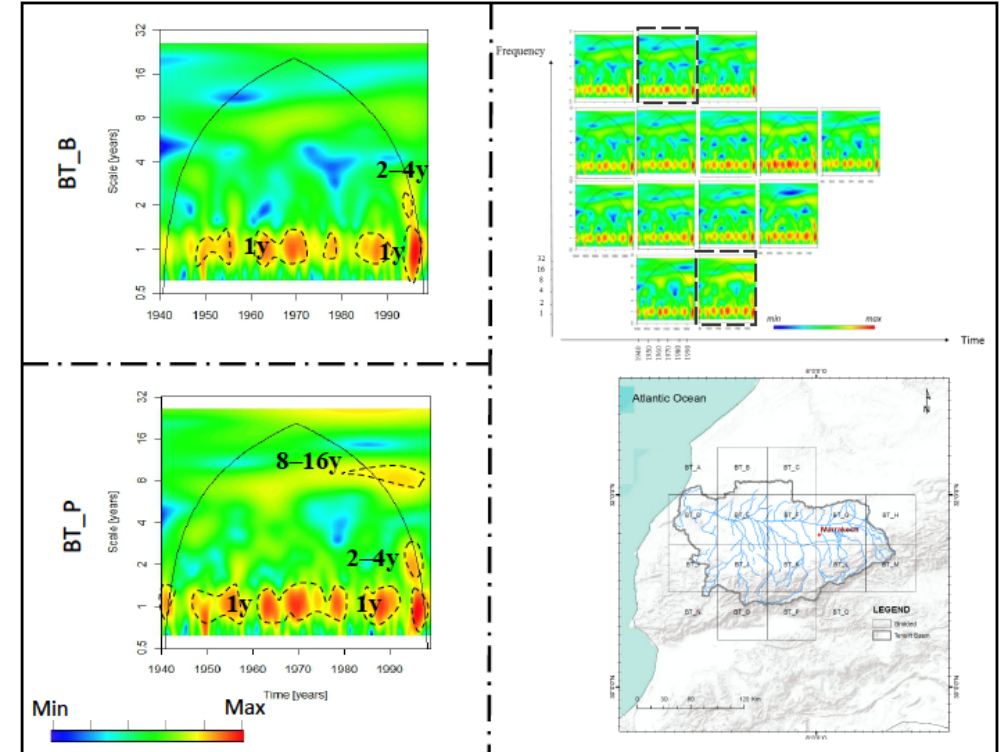
Figure 5. Subdivisions of Tensift basin from SIEREM data.